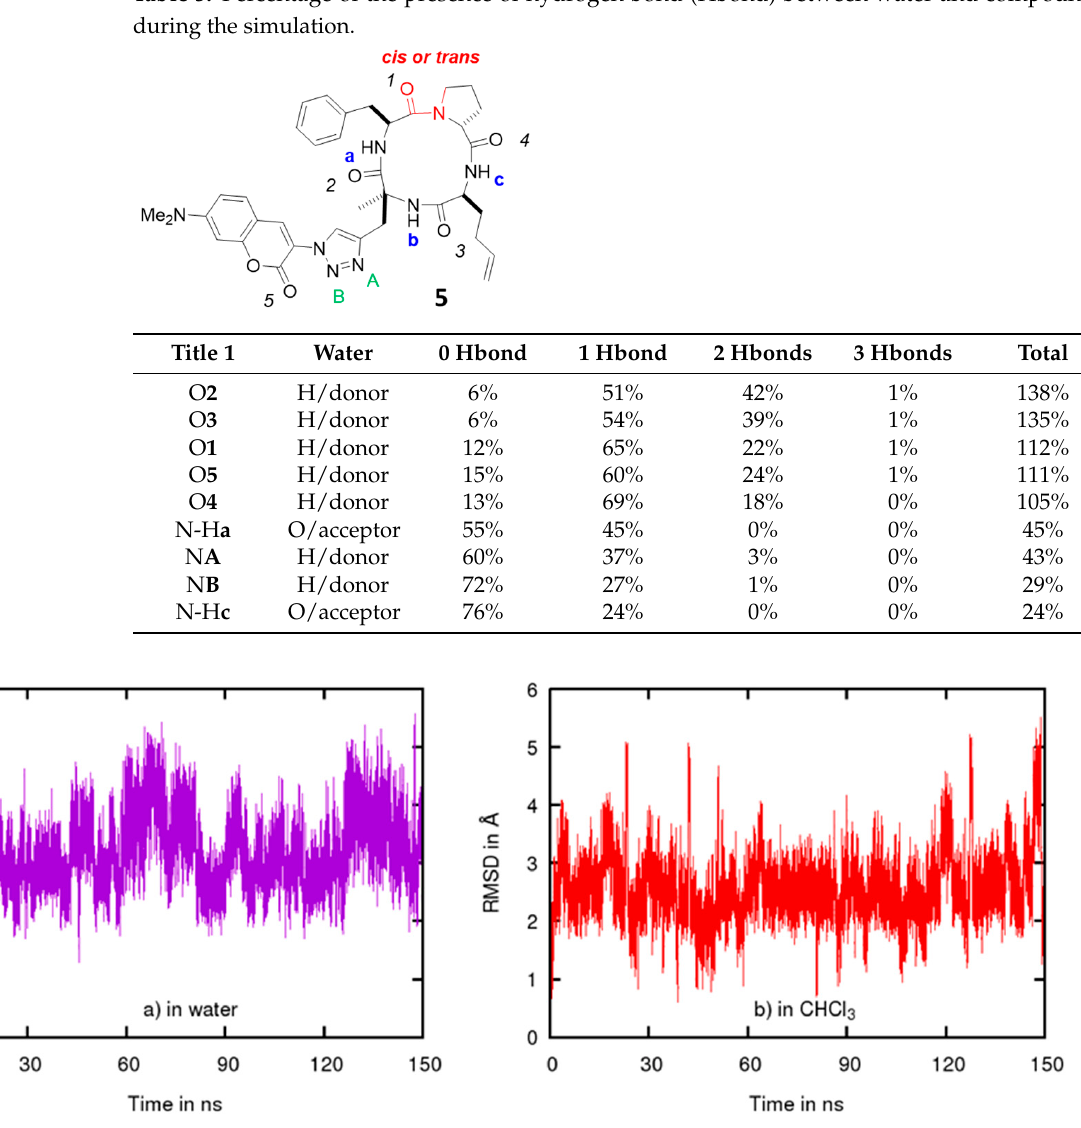
Figure 10. Evolution of the RMSD of compound 5 in Å ( a ) in water and ( b ) in CHCl 3 .